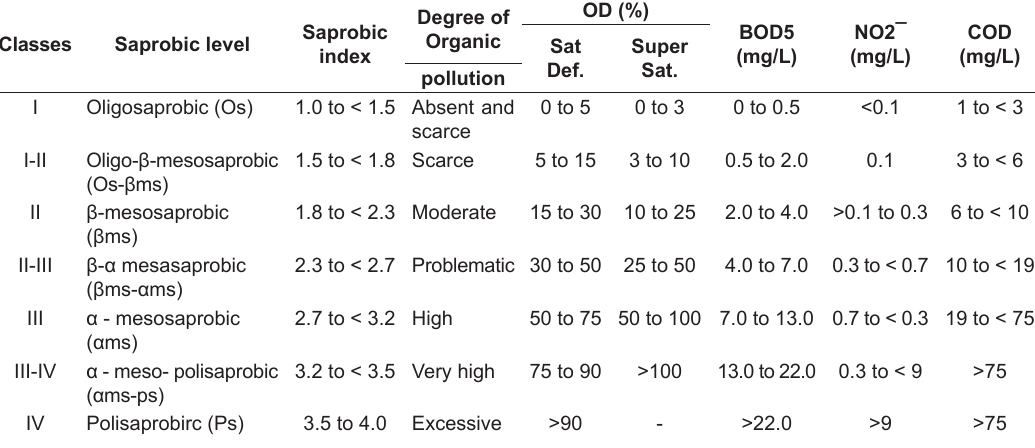
Table 2. Reference values to saprobiotic levels, based on physical and chemical parameters (Junqueira & Campos, 1998). Sat Def. (Saturation defiance), Super Sat. (Super Saturation), COD (Chemical oxygen demand) and BOD (Biochemical oxygen